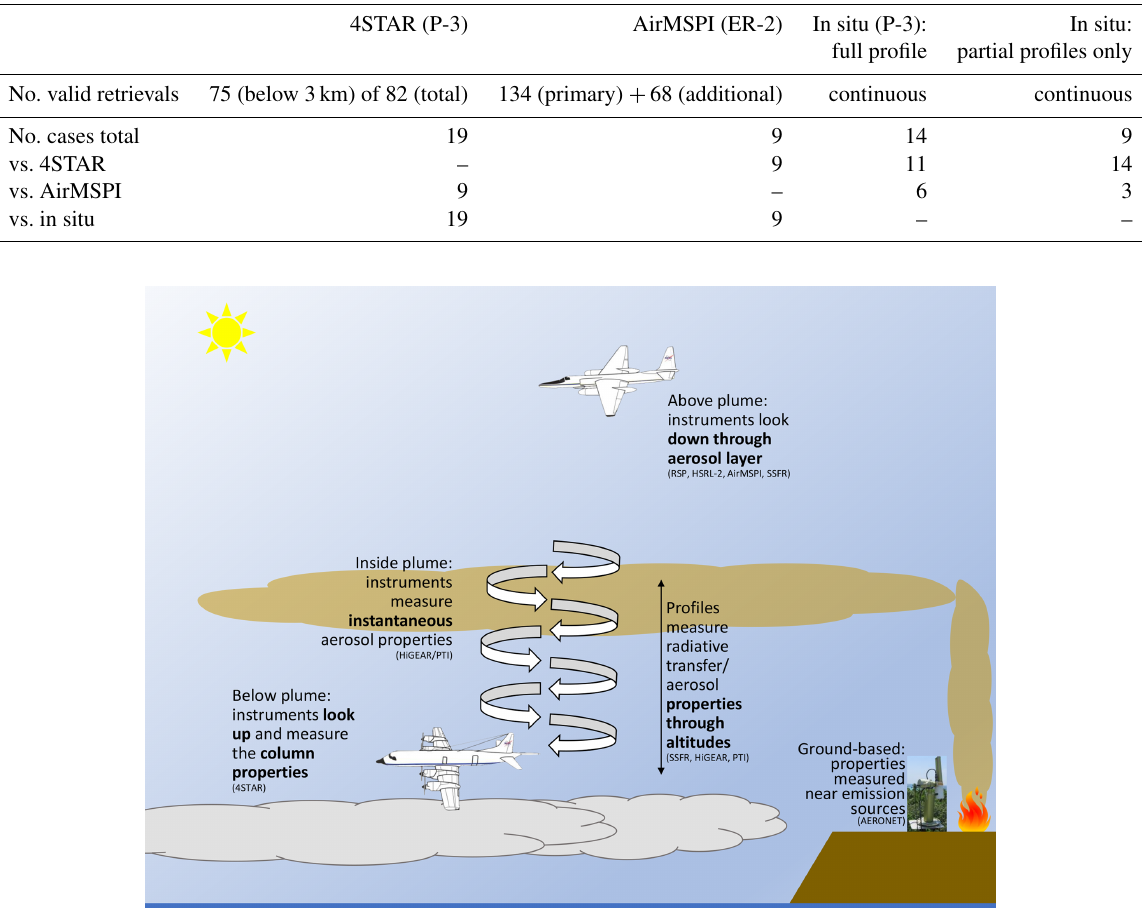
Table 2. Summary of data available for instruments with multiple comparison cases (i.e., from 4STAR, AirMSPI, and in situ instrumentation), for campaign-wide statistics (top row; Sect. 4) and for comparison with other instruments (lower rows; Sect. 3).